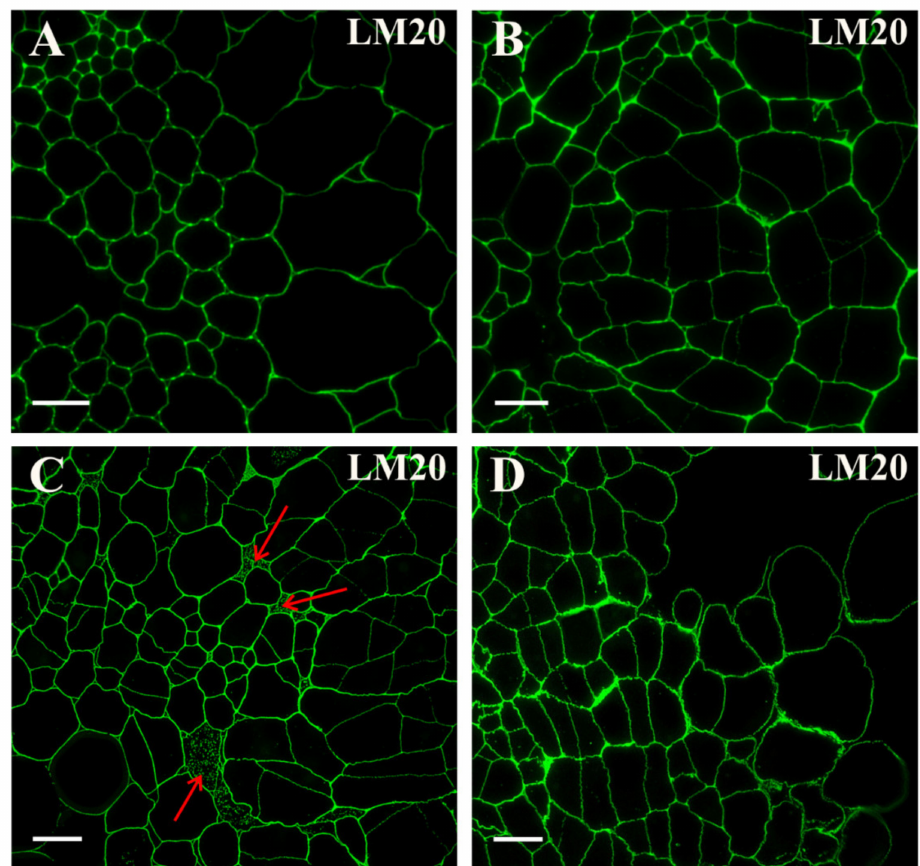
Figure 3. Distribution of the pectic epitope that is detected by the LM20 antibody in the explant cells. ( A ) Signal presence in the cell walls of all of the tissues. ( B ) After four days of the culture signal still present in the walls of all of the cells. ( C ) On the next day, the continuous wall signal in all of the explant cells and punctate signals in intercellular spaces (red arrows) were detected. ( D ) The hypocotyl after 18 days of the culture with clear continuous wall signal in all of the explant cells, including the separated ones. Scale bars: ( A – D )—10 µ